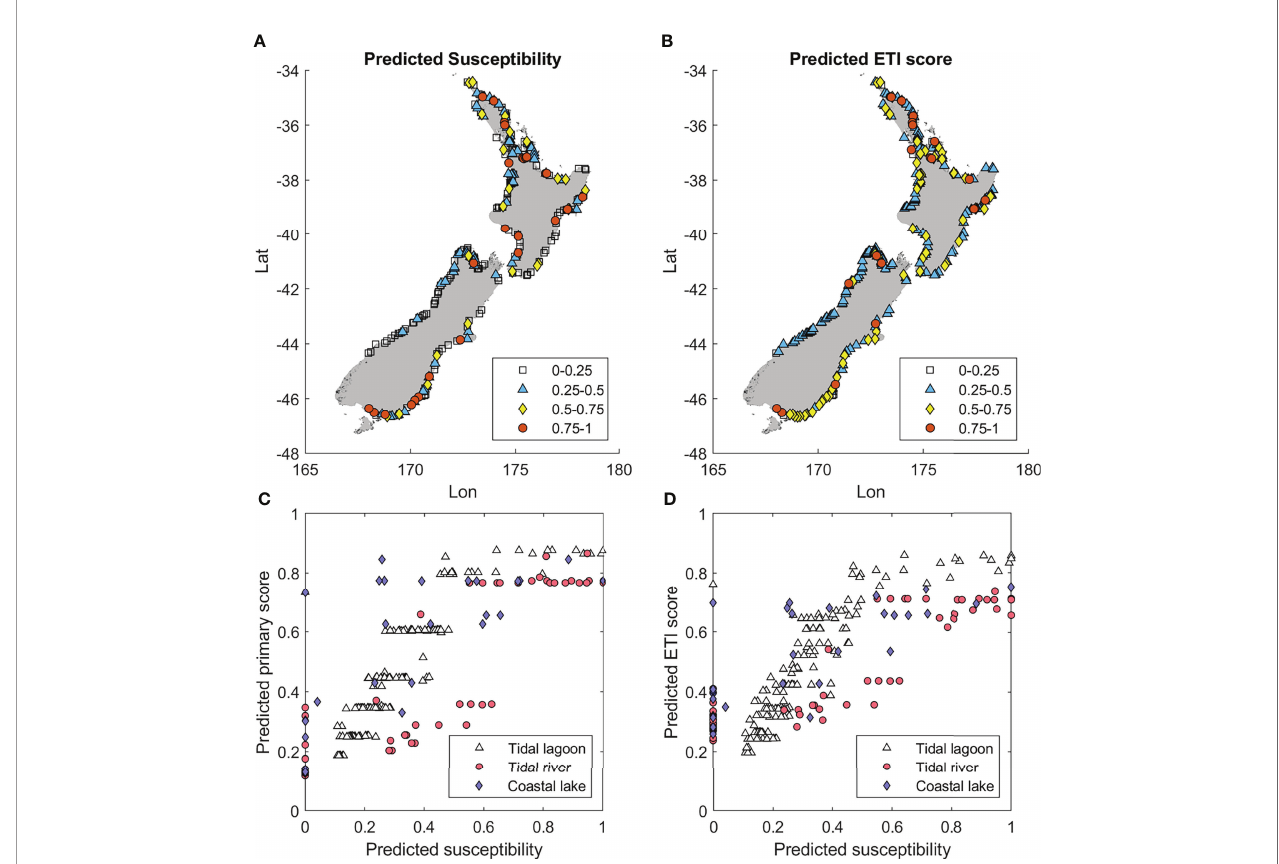
FIGURE 6 | (A) Predicted eutrophication susceptibility from ETI Tool 1 (Plew et al., 2020), (B) Predicted ETI Tool 3 BBN score, (C) Comparison of ETI Tool 1 susceptibilities and BBN-predicted primary scores, and (D) ETI Tool 1 susceptibilities and BBN-predicted ETI